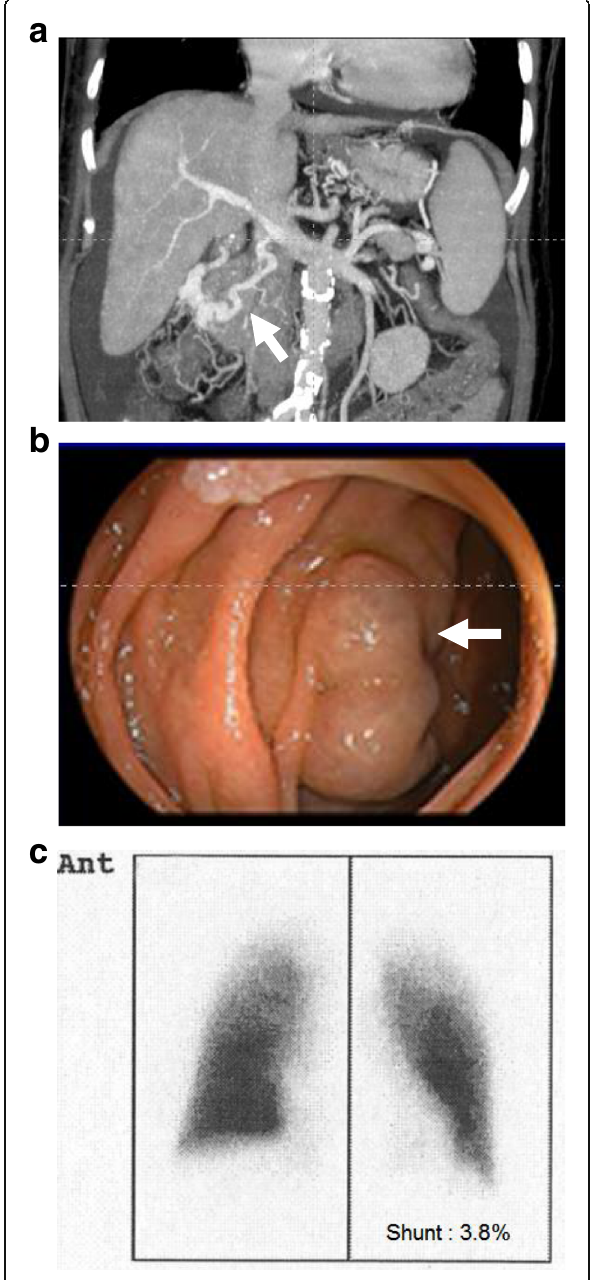
Fig. 1 A preoperative coronal section image of CT scan and right spleno-renal shunt ( a and white arrow, respectively). A preoperative image of upper gastrointestinal endoscopy and varix ( b and white arrow, respectively). A preoperative radiolabeled technetium macroaggregated-albumin (99mTc-MAA) perfusion scan ( c anterior image) showing the absence of right to left shunt (3.8%, similar to